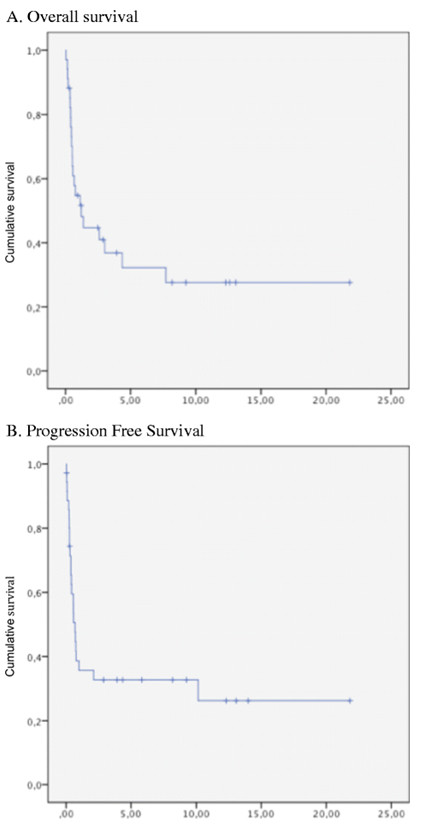
(A) Overall survival (OS) for the entire cohort. (B) Progression-free survival (PFS) for the entire cohort.